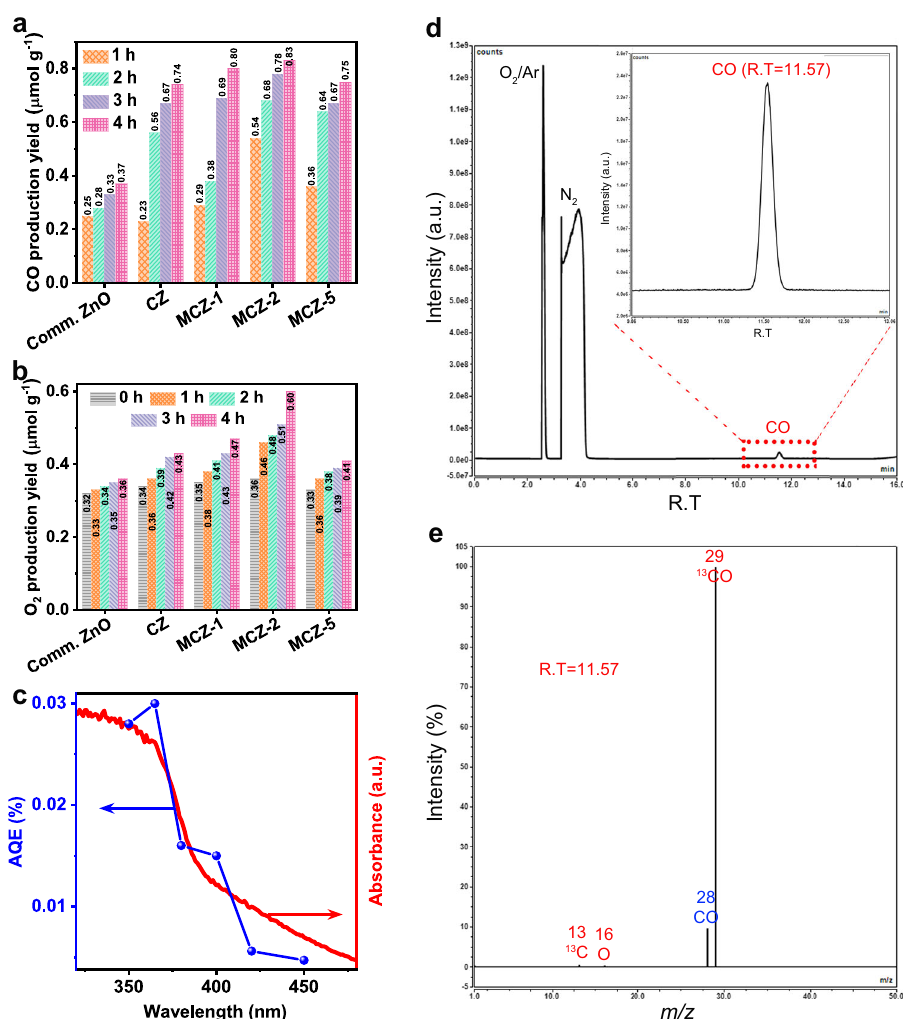
Fig. 4 The photoresponse of the prepared photocatalysts. Photocatalytic CO 2 reduction performance of comm. ZnO and the prepared samples: time course of a CO and b O 2 production yields. c Wavelength dependence of the AQE and the UV – vis absorption spectrum of 2% Mn, C-ZnO sample. d Isotopic labeling chromatogram using 13 NaHCO 3 as a carbon source and e GC-MS data of the peak at retention time (RT) of 11.57 coressponding to 13 CO.